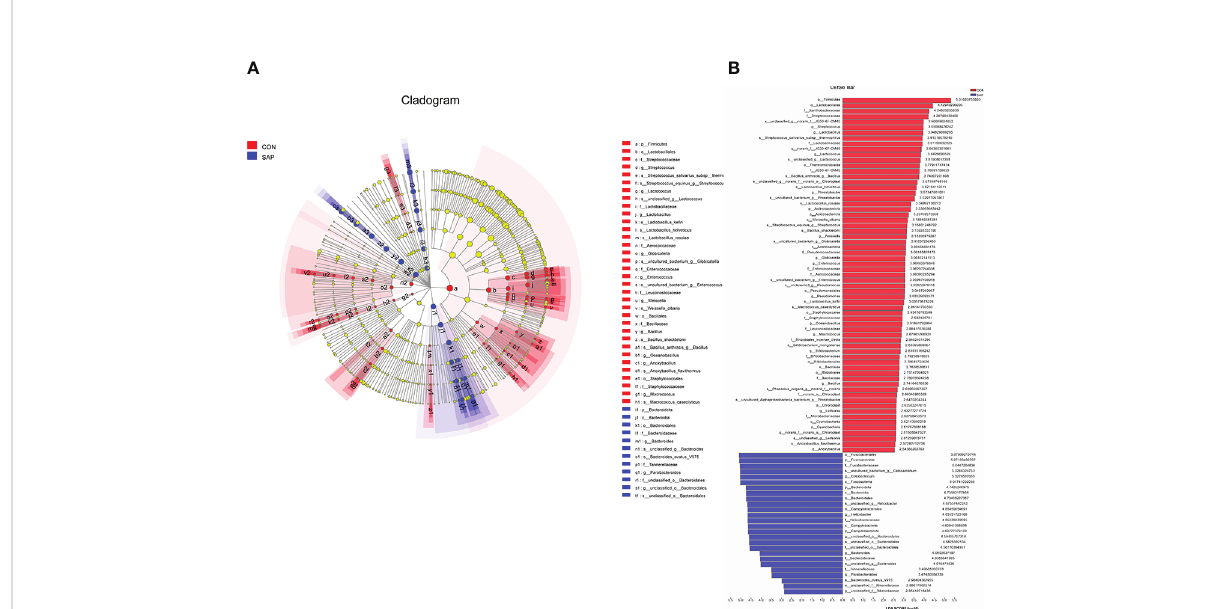
FIGURE 6 LEfSe multilevel species hierarchy tree (A) and LDA discriminant result table (B) (phylum-species) ( n = 4). In the hierarchy tree diagram, red- colored nodes represent the microbial groups in the CON group are signi fi cantly higher than the SAP group. Blue-colored nodes represent the microbial groups in the SAP group are signi fi cantly higher than the CON group. The LDA discriminant column chart counts the microbial groups with signi fi cant effects in the two groups. The larger the LDA score is, the greater the impact of species abundance on the different